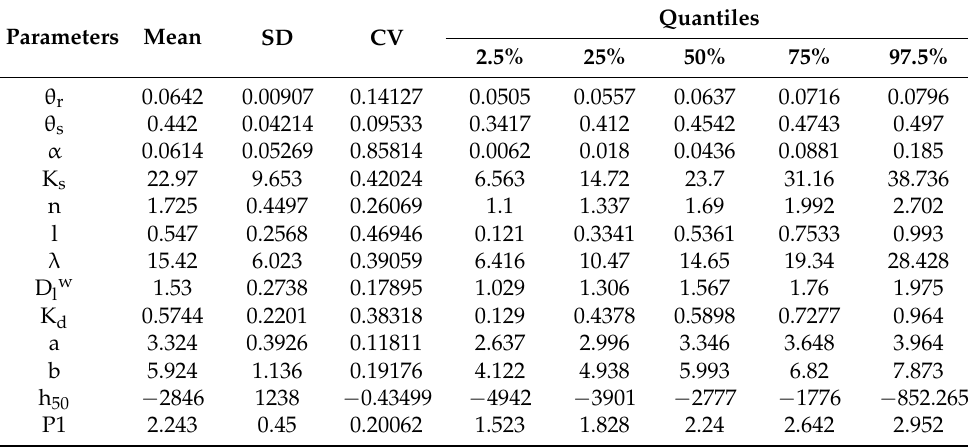
Table 5. Posterior distribution of the HYDRUS-1D parameters for simulating soil salinity dynamics. Parameters